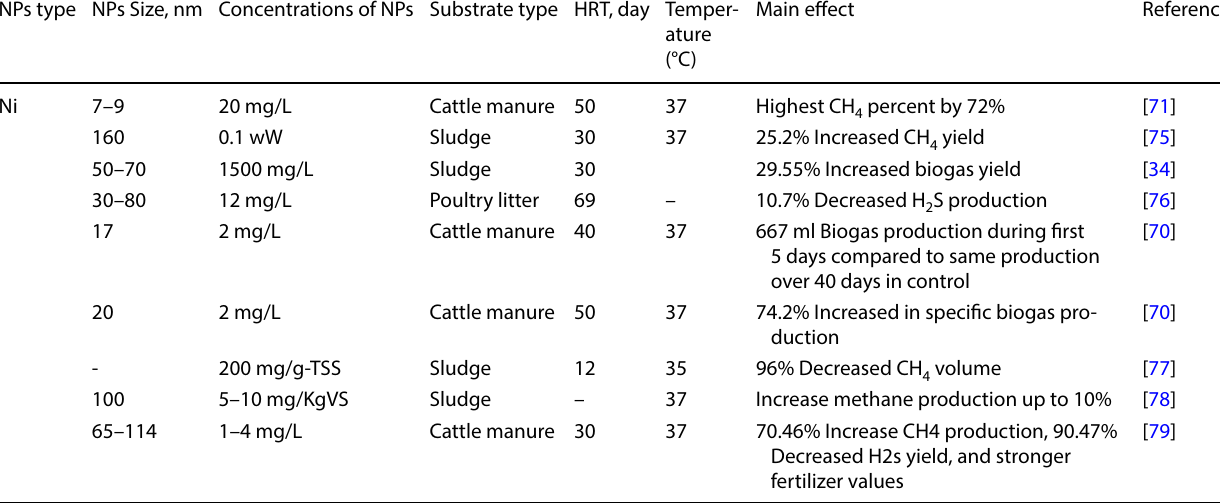
Table 2 Effects of nickel nanoparticles on the performance of biogas production process and effluent quality NPs type NPs Size, nm Concentrations of NPs Substrate type HRT, day Temper-